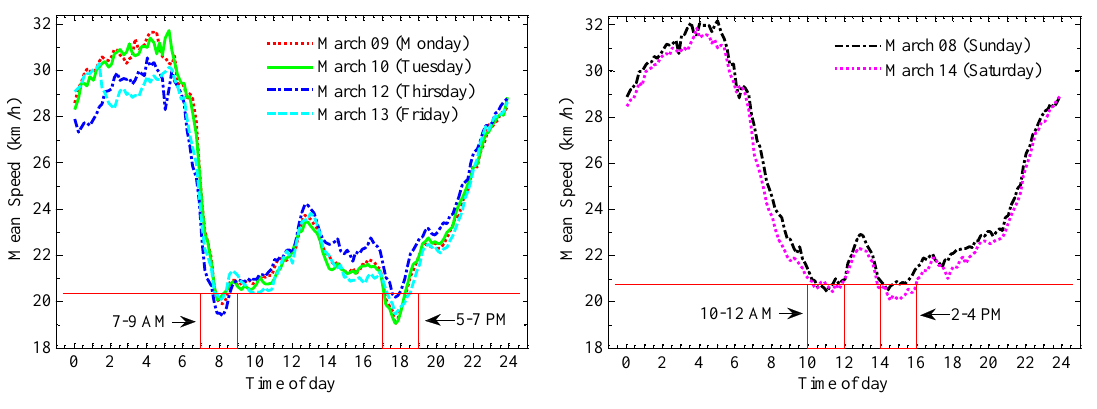
Figure 4. Mean speed of taxies during workdays ( left panel ) and weekends ( right panel